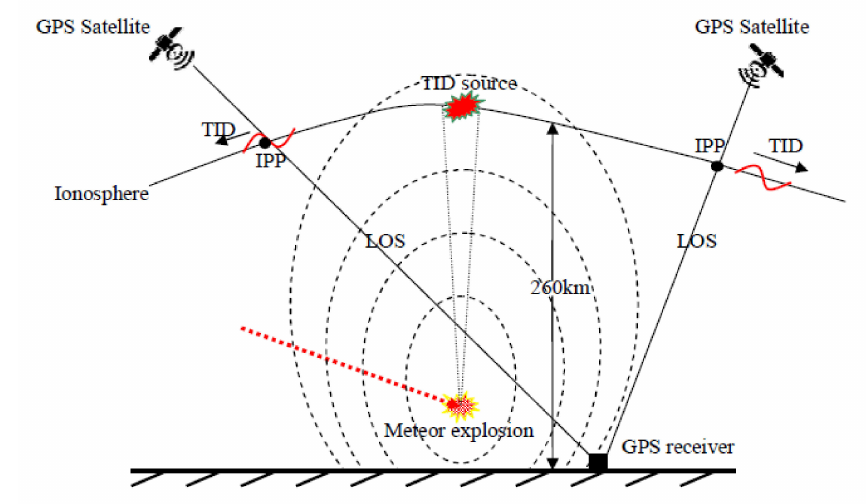
Figure 16. Meteor explosion induced ionospheric disturbance